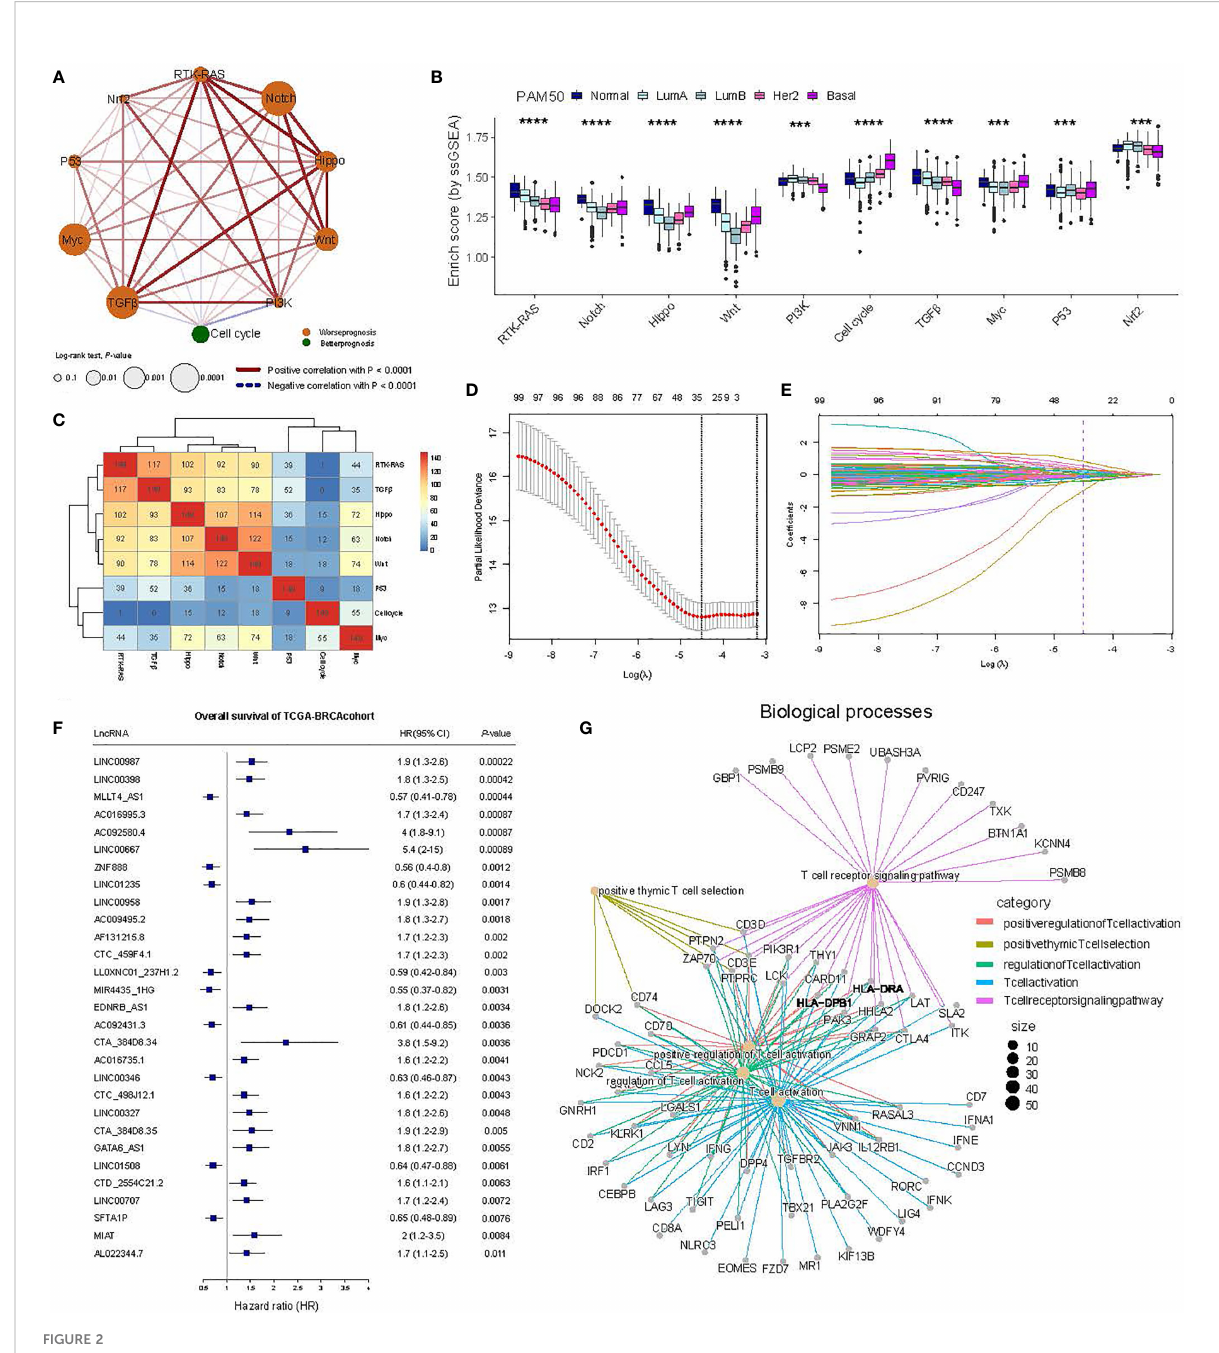
FIGURE 2 Identi fi cation of oncogenic signaling pathway-associated lncRNAs using TCGA-BRCA transcriptome data. (A) Interaction of 10 oncogenic signaling pathways. The size of the circles represents the prognostic effect of each cell type, while the color of the fi ll is scaled by the P-value. Red and blue colors indicate positive and negative correlations, respectively. (B) A comparison of the ESs of the oncogenic signaling pathways in the PAM50 subtypes. The Wilcoxon rank-sum test was used for statistical analysis. *** p ≤ 0.001, **** p ≤ 0.0001. (C) Heat map showing the number of overlaps between lncRNAs highly associated with speci fi c oncogenic signaling pathways and other pathways using hierarchical clustering. The top 5% of the lncRNAs associated with speci fi c oncogenic signaling pathways were selected. The upper bound of the color bar is 150. (D) The least absolute shrinkage and selection operator (LASSO) regression model revealed partial likelihood deviance in the 10-fold cross- validation. (E) The LASSO coef fi cient pro fi les of prognosis-related lncRNAs in 10-fold cross-validation. (F) The forest plot of 29 candidate prognosis-related lncRNAs associated with OS in the TCGA-BRCA cohort. (G) Gene ontology (GO) functional enrichment analysis for mRNAs with coexpressed